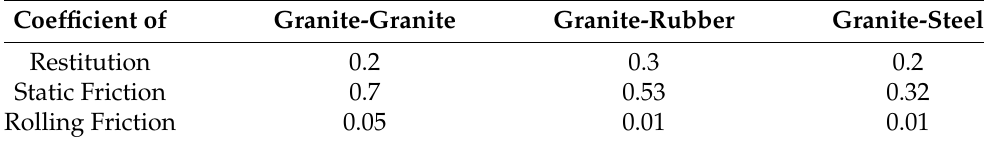
Table 1. Calibrated parameters.